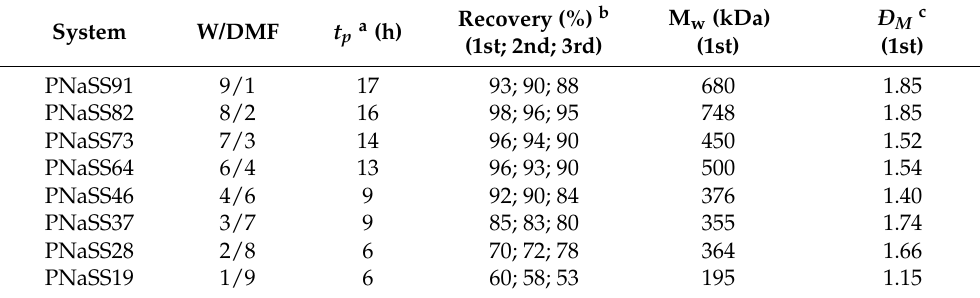
Table 1. Polymerization data and